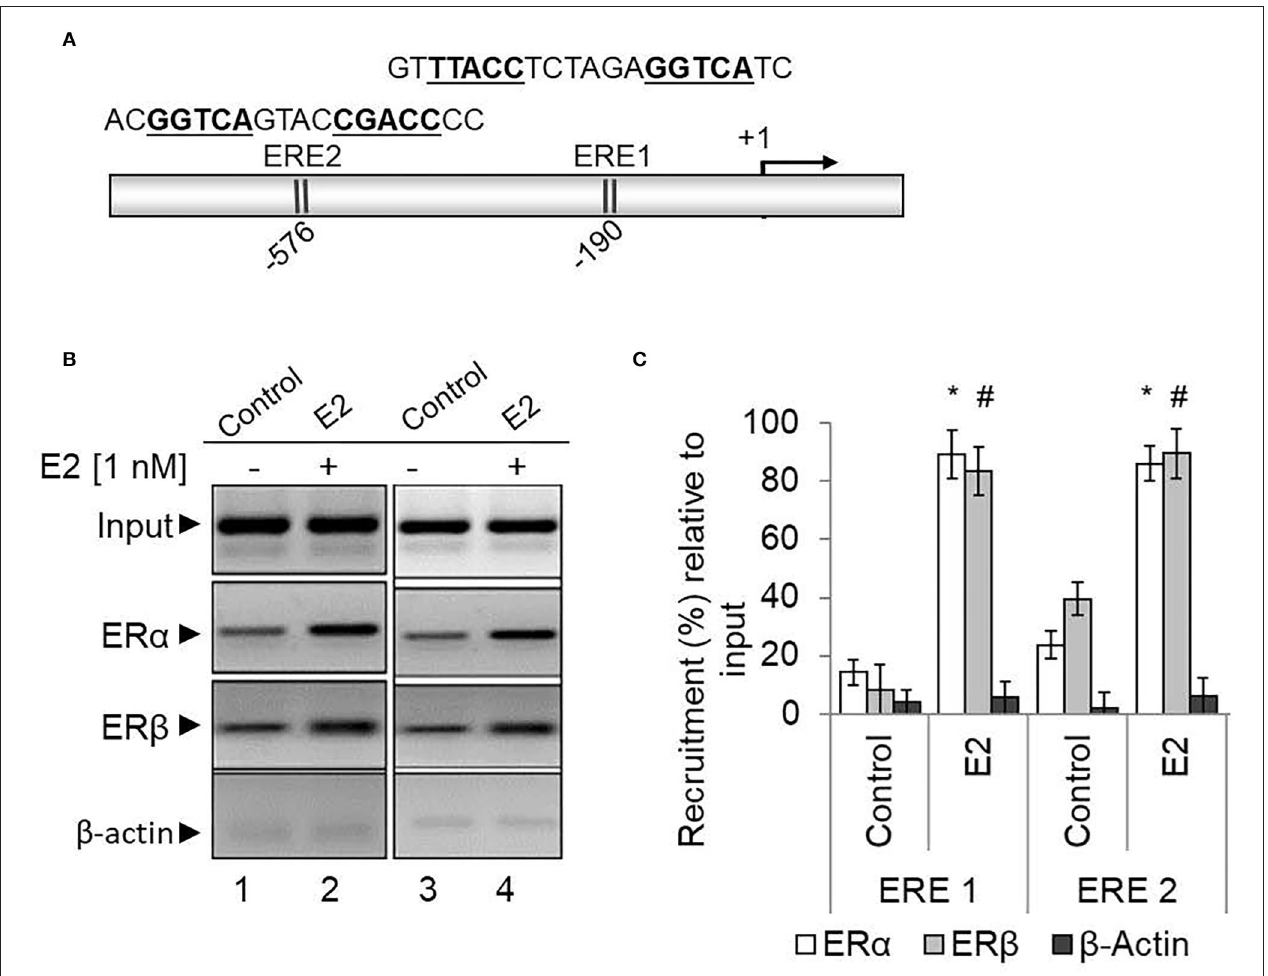
FIGURE 6 | ER α and ER β enrichment on the HOXA5 promoter ERE in the presence of E2. The HOXA5 promoter contains two putative ERE regions (ERE1 and ERE2) near the transcription start site (A) . E2-treated (nM E2 for 6h) and control (untreated) MCF7 cells were analyzed by ChIP assay using antibodies against ER α , ER β , and β -actin (control). The ChIP DNA was analyzed by regular PCR (agarose gel analysis, B ) and qPCR (C) using HOXA5 promoter primers (ERE1 and ER2 regions). Bars indicate averages ± standard errors ( n = 3). *denotes p < 0.0001 compared to ER α ChIP control; # denotes p < 0.0001 compared to ER β ChIP control for both the